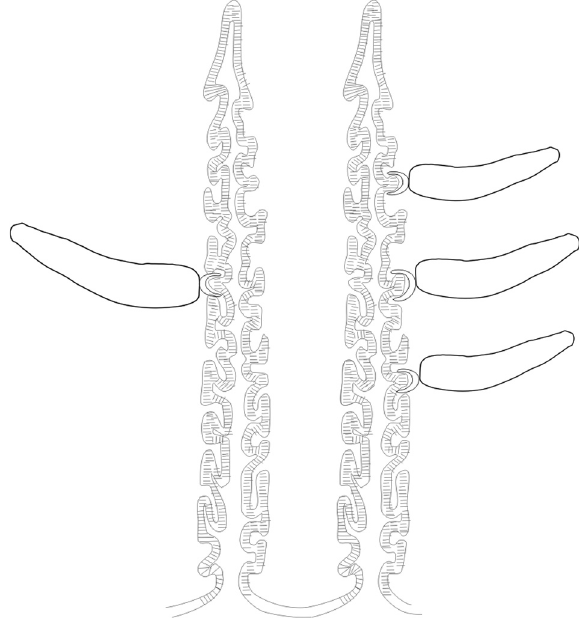
Figure 6. Mode of attachment of Triloculotrema euzeti n. sp. to the olfactory